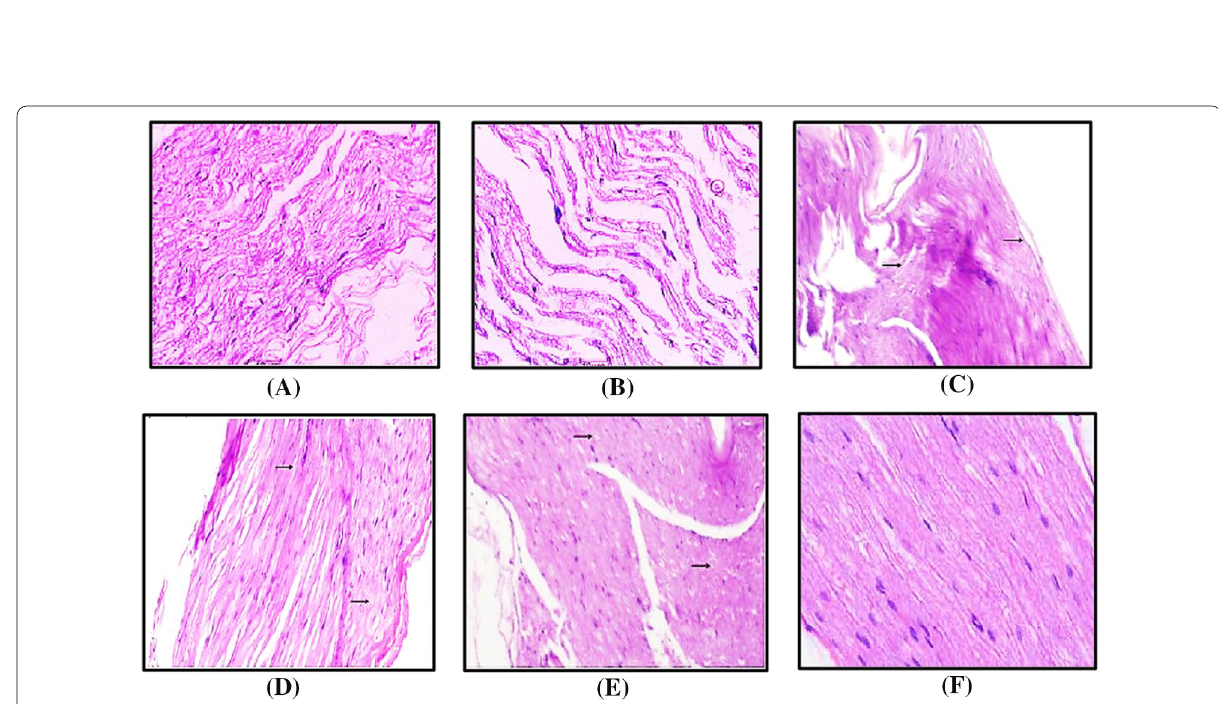
Fig. 8 A – F Effect of chronic treatment of MESI on histoarchitecture of sciatic nerve in STZ-induced diabetic neuropathy. Photomicrographs of sections of the sciatic nerve from rats stained with H & E. A Normal non-diabetic (ND), B Diabetic (STZ) control, C STZ (200), E STZ MESI (400), and F STZ Metformin (500)-treated rats (microscopic examination under 400 + + and MESI (400): Methanolic extract of Sphaeranthus indicus Linn (MESI) 100, 200, and 400 mg/ kg, p.o. treated